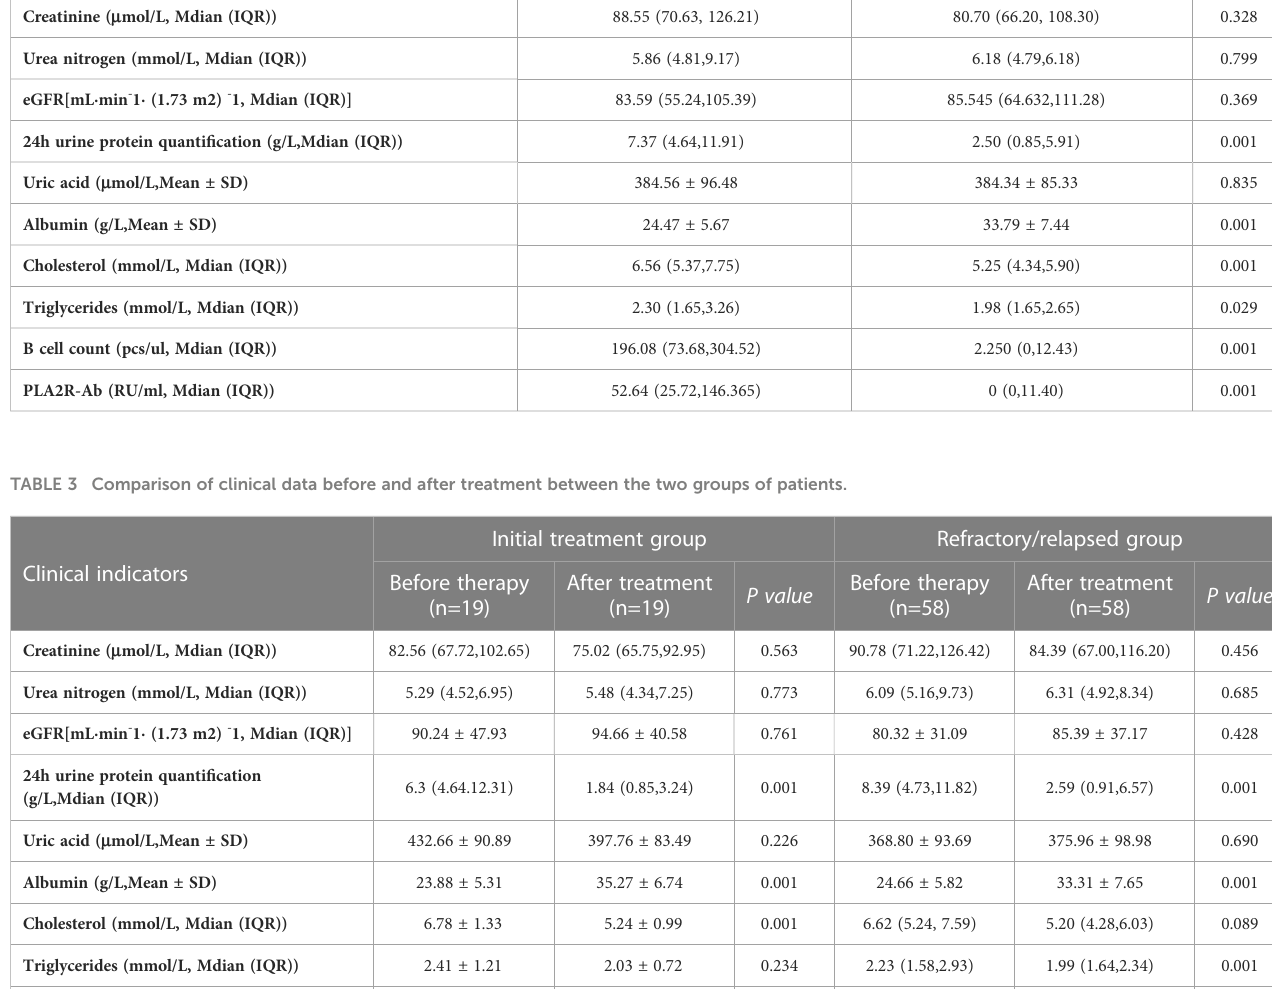
TABLE 2 Comparison of clinical data of patients with IMN before and after treatment. Clinical indicators Before therapy